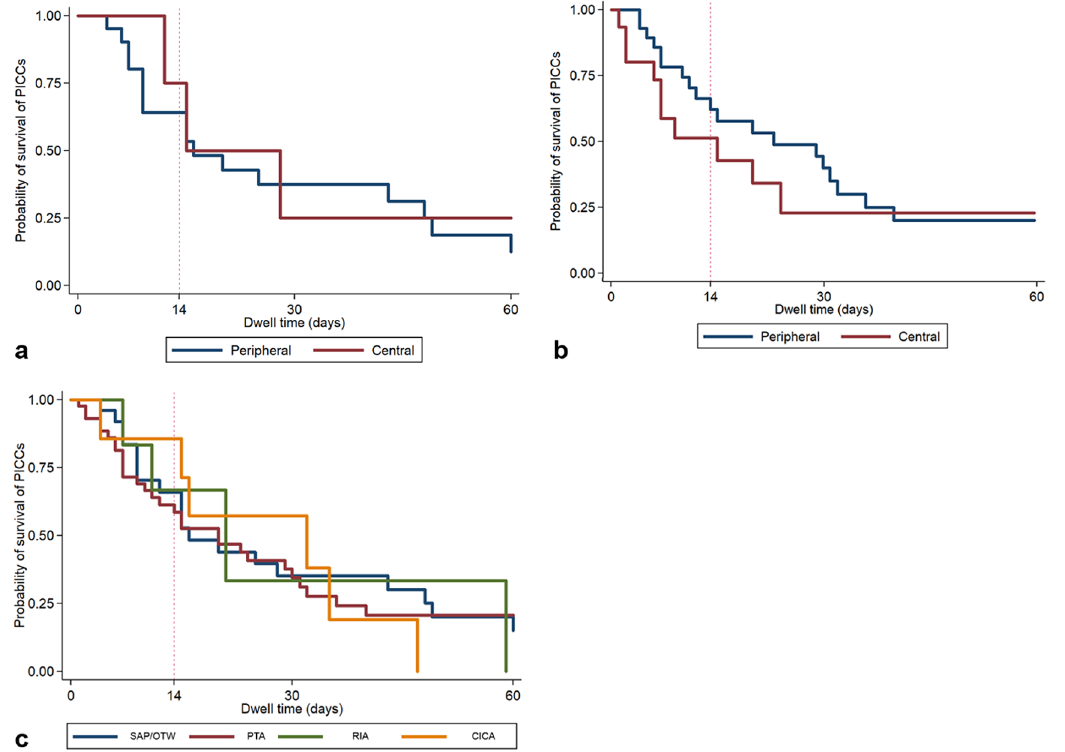
Figure 4. Kaplan–Meier estimate of dwell time of PICC placed, ( a ) using the SAP/OTW technique, ( b ) using PTA technique, and ( c ) by the last technique. The vertical dashed line depicts the time point of 14 days, while the end of x-axis represents the time point of 60 days. These time points are the two end points for assessing clinical success rate. PICC peripherally inserted central catheter, SAP/OTW selecting alternative pathway/over the wire technique, PTA percutaneous transluminal angioplasty technique, RIA re-puncture in ipsilateral arm technique, CICA catheter placement in contralateral arm technique.